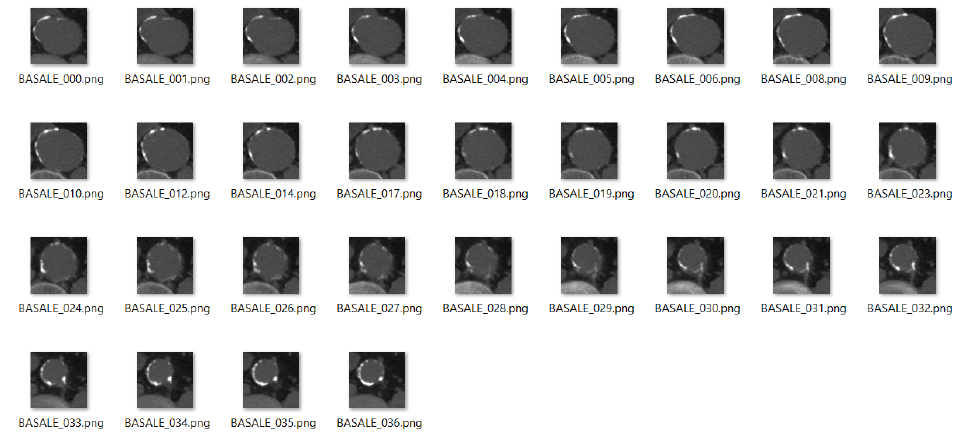
Figure 15. Basal image sequence for patient ID 105.